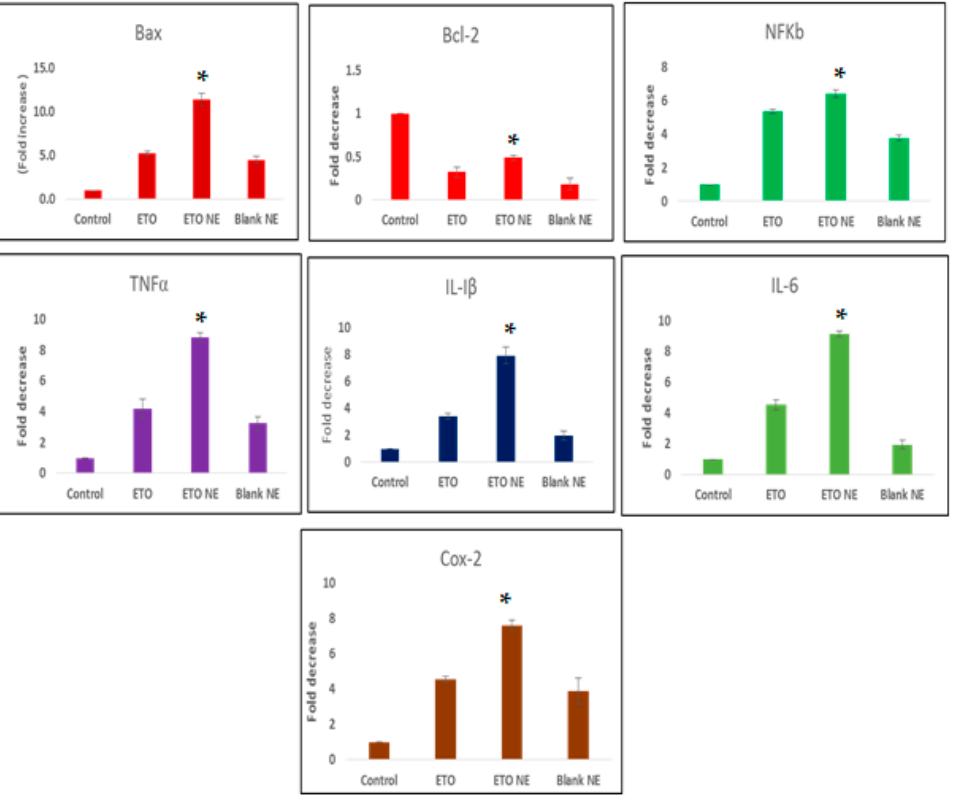
Figure 11. Effect of different formulations on molecular markers that play an important role in the progression of cancer. Data are expressed as (mean ± SD, n = 3), where * denotes significant difference between ETO NE ( p < 0.05) vs. free ETO, blank NE and control group.